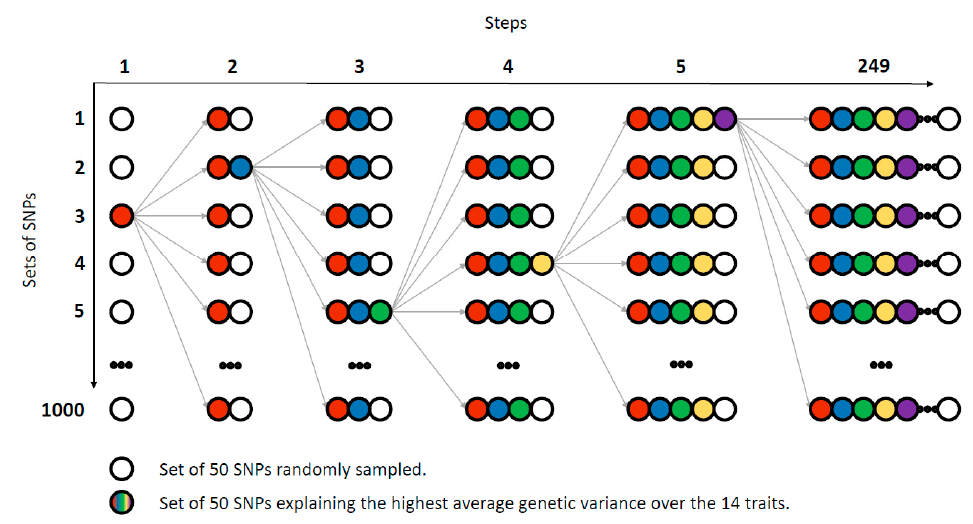
Figure 1. Graphic description of the stepwise multiple regression analysis. This figure graphically represents the selection method applied to the stepwise regression analysis, which was based on adding 50 new SNPs each step of the analysis, until all the variants were included. Each circle represents a set of 50 randomly selected SNPs. The colours represent the groups of SNPs which explained the highest average genetic variance over the 14 traits selected in the subsequent steps, first step red, second blue, and so on).